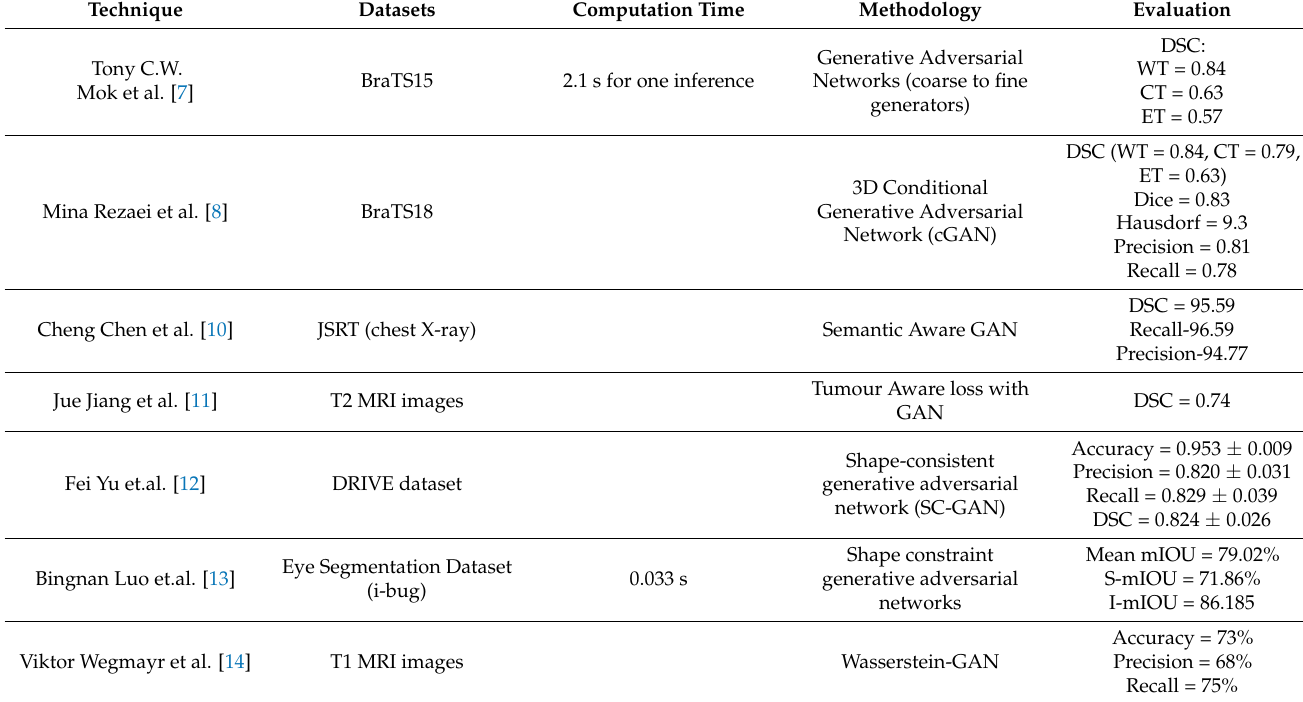
Table 1. Literature survey of GAN-based